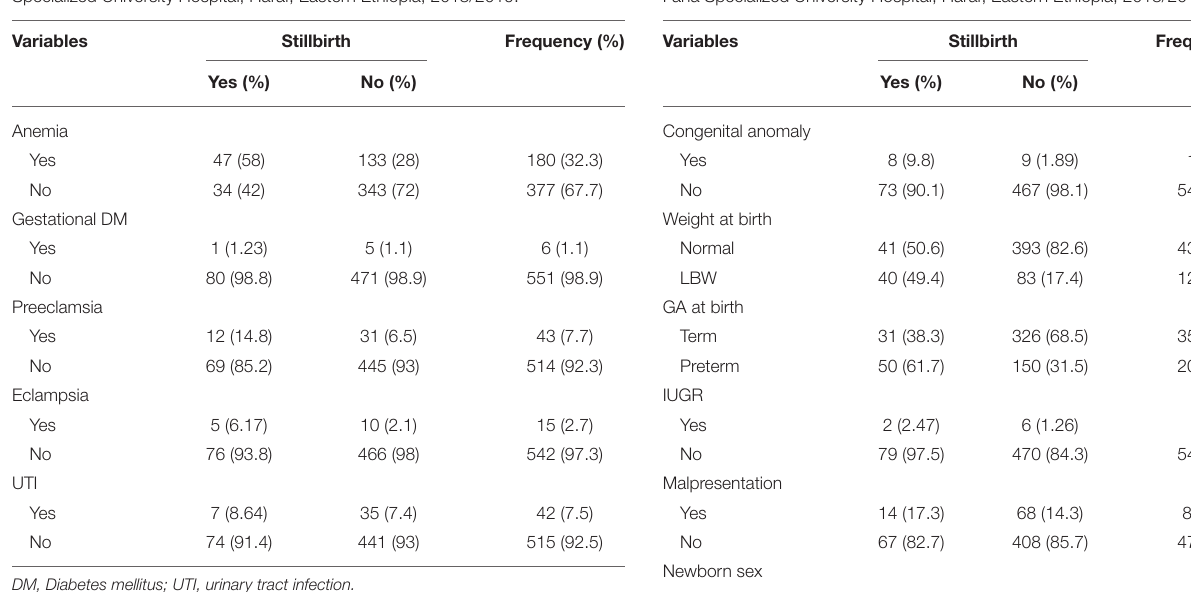
TABLE 4 | Fetal-related characteristics of study participants ( n = 557), Hiwot Fana Specialized University Hospital, Harar, Eastern Ethiopia, 2018/2019.